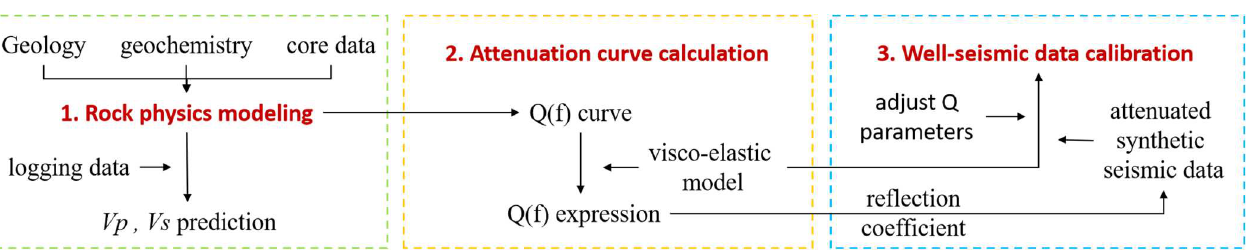
Figure 1. Procedures of the proposed well-to-seismic calibration method.